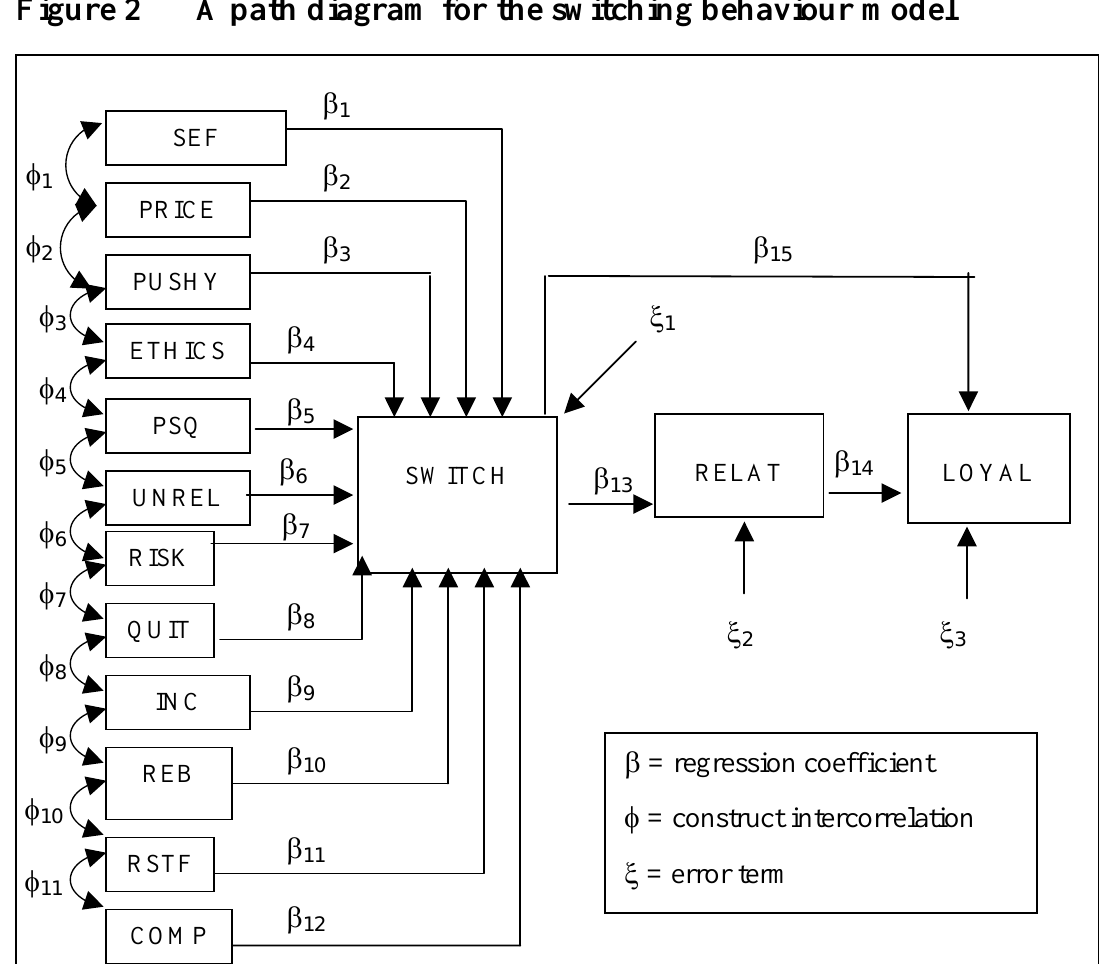
A path diagram for the switching behaviour